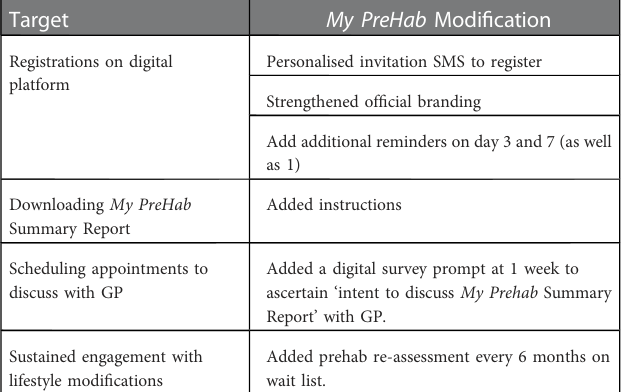
TABLE 2 Modi fi cations made to the My preHab pathway after initial user testing.